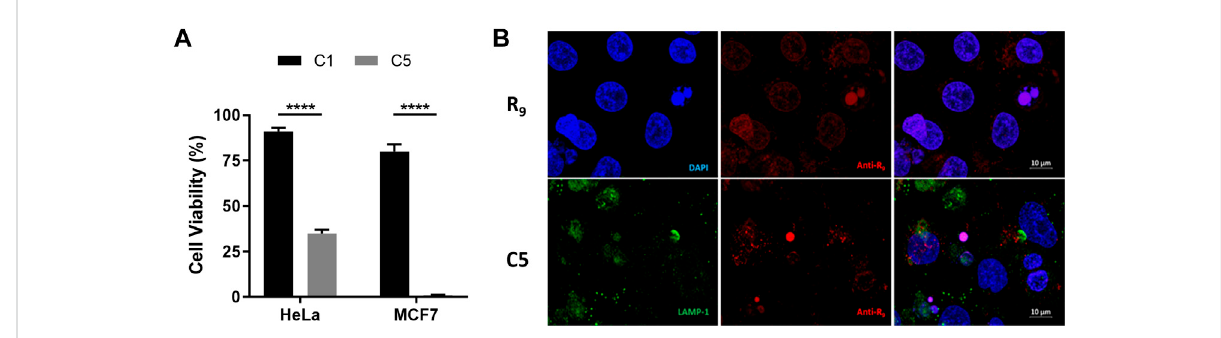
FIGURE 6 Cellular localization and cytotoxicity ef fi cacy of cell-penetrating peptide-conjugated Cu(II) complex C5. (A) Cell-viability assays for complexes C1and C5 (100 µM)in HeLaand MCF7cell lines at30 min or4 htreatment times,after which thecell media was replaced by fresh medium and cells incubated for extra time until reaching a total of 72 h. Statistical differences were determined using a one-way ANOVA, with p values as: **** p ≤ 0.0001. (B) Cellular distribution of R 9 peptide (control experiment) and complex C5 after 4 h incubation in HeLa cancer cells. HeLa cells were fi xed and stained with Anti-R 9 (red) and anti-LAMP-1 (green, for lysosomes) antibodies, and DAPI (blue, nuclei). Last column shows the merged